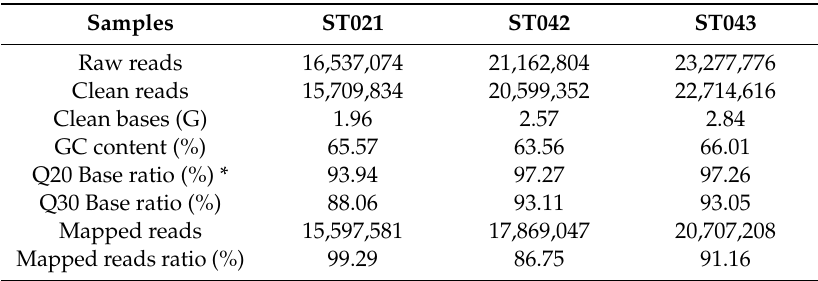
Table 2. Statistical analysis of RNA sequence data and genome